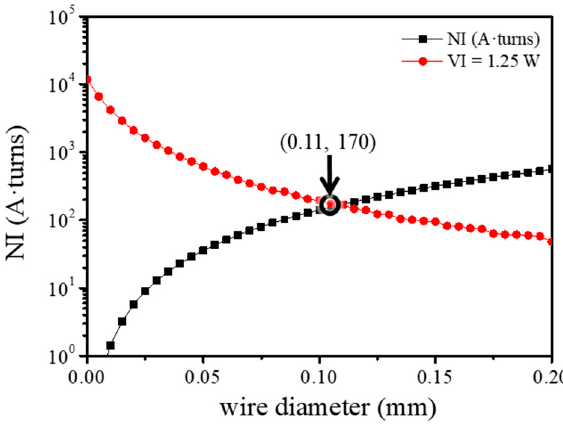
Figure 4. Magnetomotive force according to the wire diameter of the solenoid coil and limited power consumption.